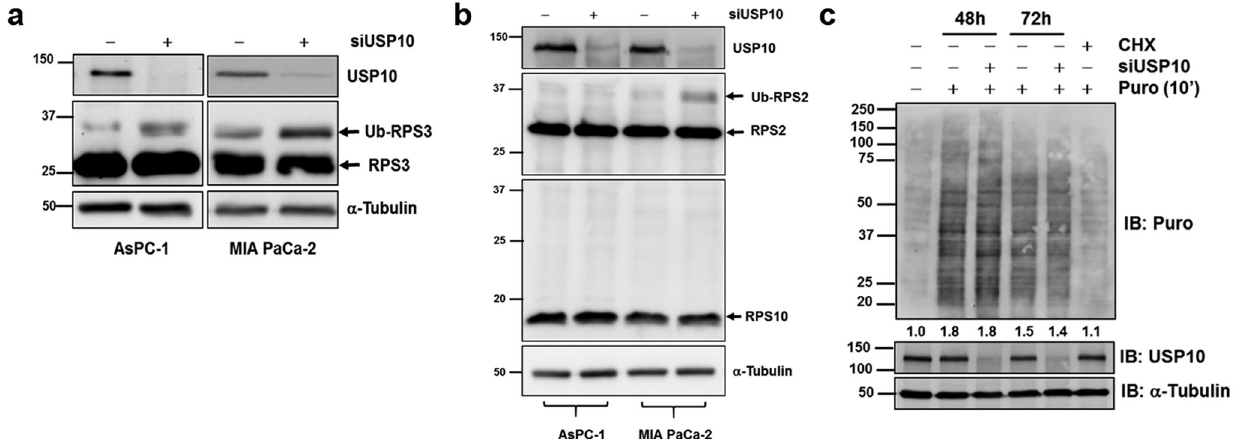
Fig. 3 USP10 deubiquitinates ribosomal subunits. a , b Monoubiquitination changes of RPS2, RPS3, and RPS10 after USP10 depletion was evaluated by immunoblotting. α Tubulin was used as loading control and ef fi cient USP10 inhibition was con fi rmed by immunoblotting. c Control and USP10 silenced cells were incubated with 10 μ g/ml of puromycin 48 h or 72 h post-transfection for 10 min prior to harvest. For negative control, cells were treated with cycloheximide (30 μ g/ml, 60 min) prior to puromycin incubation. Global protein synthesis was evaluated by anti-puromycin antibody. The numbers denote densitometric quantitation of individual lanes, normalized with respect to α - Tubulin by NIH Image